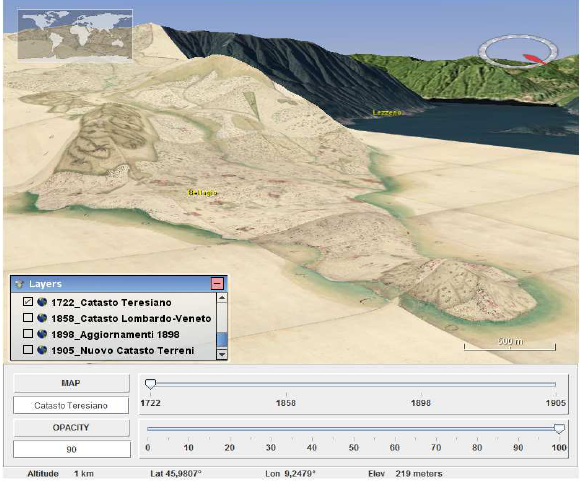
Figure 5. 3D visualization of Theresian cadastral map selected through the temporal